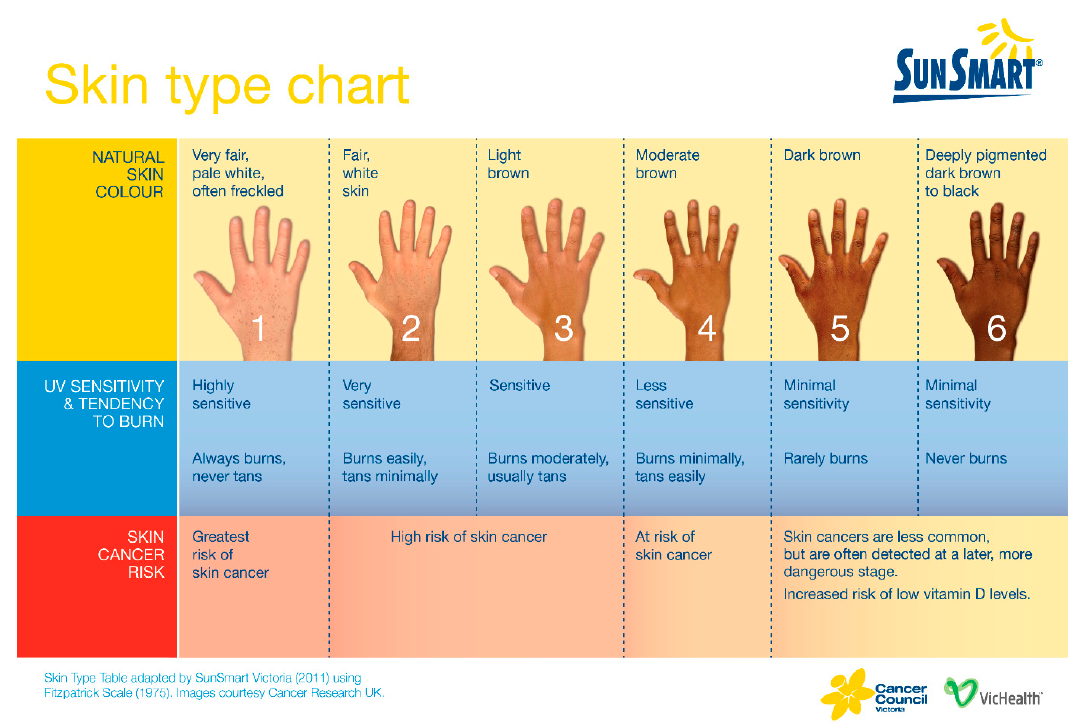
Figure 3. “Sun Smart” Guidelines for sun exposure according to skin type [20]. Copyright permission was obtained from the publisher.